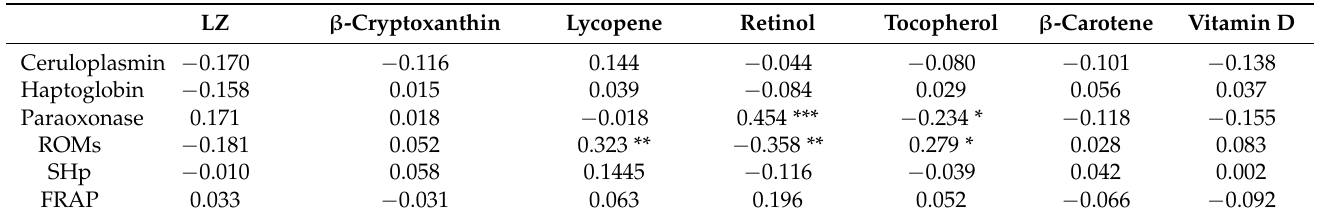
Table 4. Correlation (r) between lipid-soluble micronutrients and markers of inflammation.